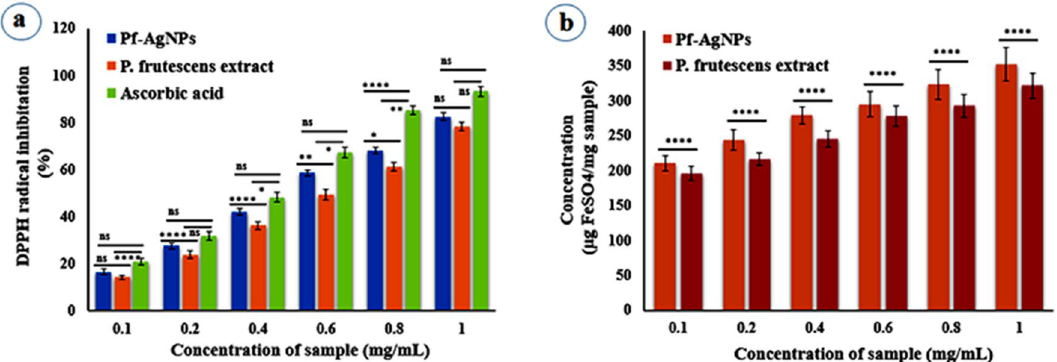
Figure 6. Antioxidant activity of the extract of Perilla frutescens and Pf-AgNPs ( a ) DPPH, ( b ) FRAP. Error bar represents standard deviation of mean. * p ≤ 0.05, ** p ≤ 0.01, **** p ≤ 0.0001. Significant difference within a parameter between two lines is denoted by asterisk, and ns, means p > 0.05.